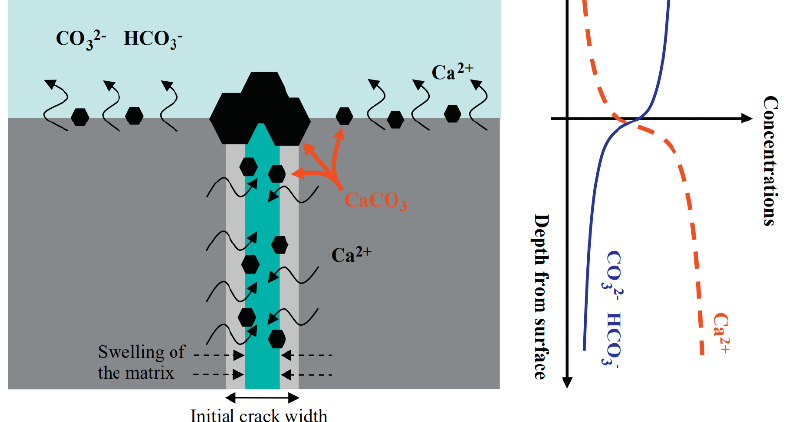
Figure 3. Schematic diagram of the crystallization of calcium carbonate. Reprint with the permis- sion from ref.[15]. Copyright 2022 Elsevier.